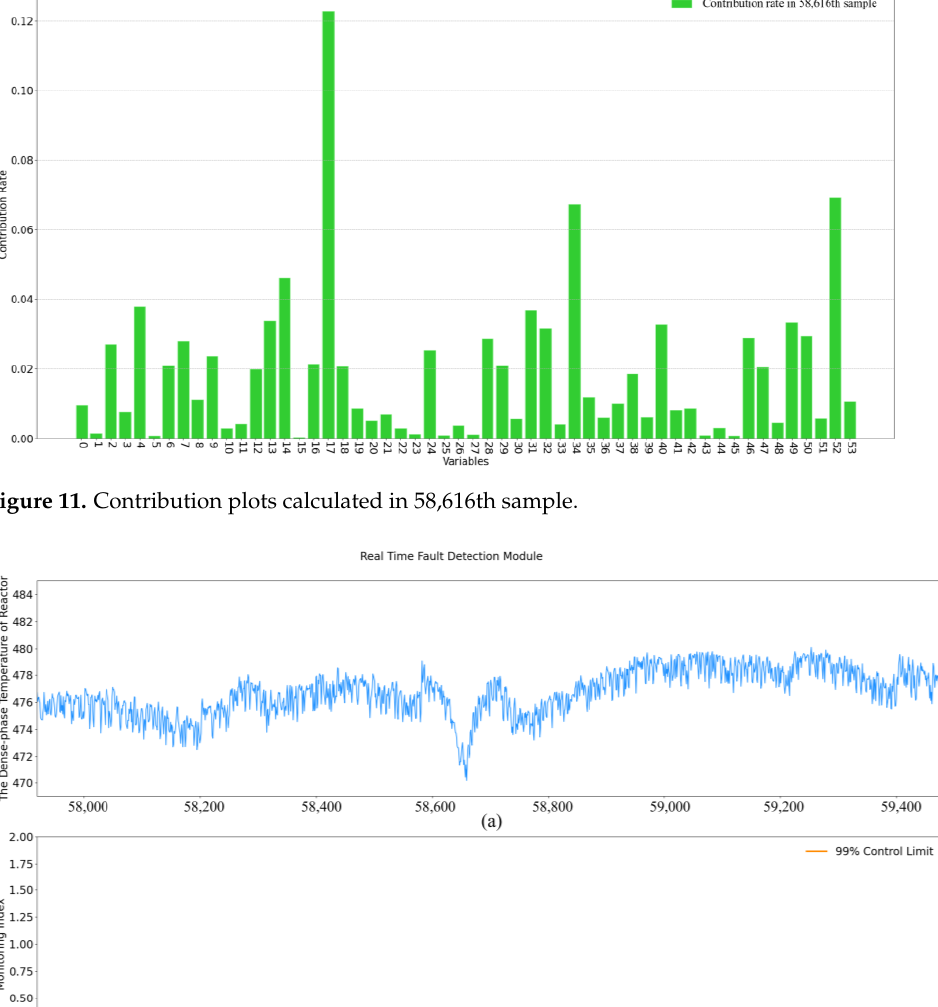
Figure 10. Process monitoring result on case one obtained by the proposed method: (a) Original data of the key variable; (b) Fault detection results.